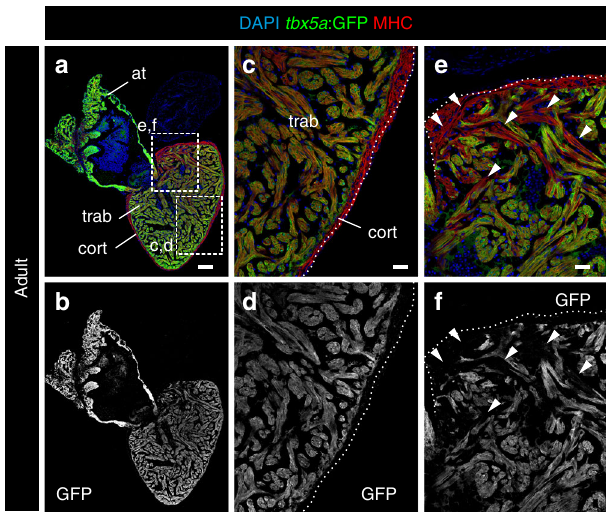
Fig. 2 Expression pro fi le of tbx5a -positive cardiomyocytes in adult zebra fi sh hearts. a , b Sagittal sections through tbx5a:GFP adult uninjured heart immunostained with GFP (green) and Myosin Heavy Chain (MHC; red). Nuclei are counterstained with DAPI (blue). c – e Zoomed views of boxed area in a . b , d , f Single channels for GFP. The trabecular myocardium is tbx5a :GFP + , whereas the cortical layer is tbx5a :GFP − . Note tbx5a :GFP − cardiomyocytes (arrowheads) in the basal part of the ventricle close to the atrioventricular canal ( n = 13/13). at, atrium; cort, cortical layer; trab, trabecular layer. Scale bars, a , b 100 μ m and c – f 25 μ